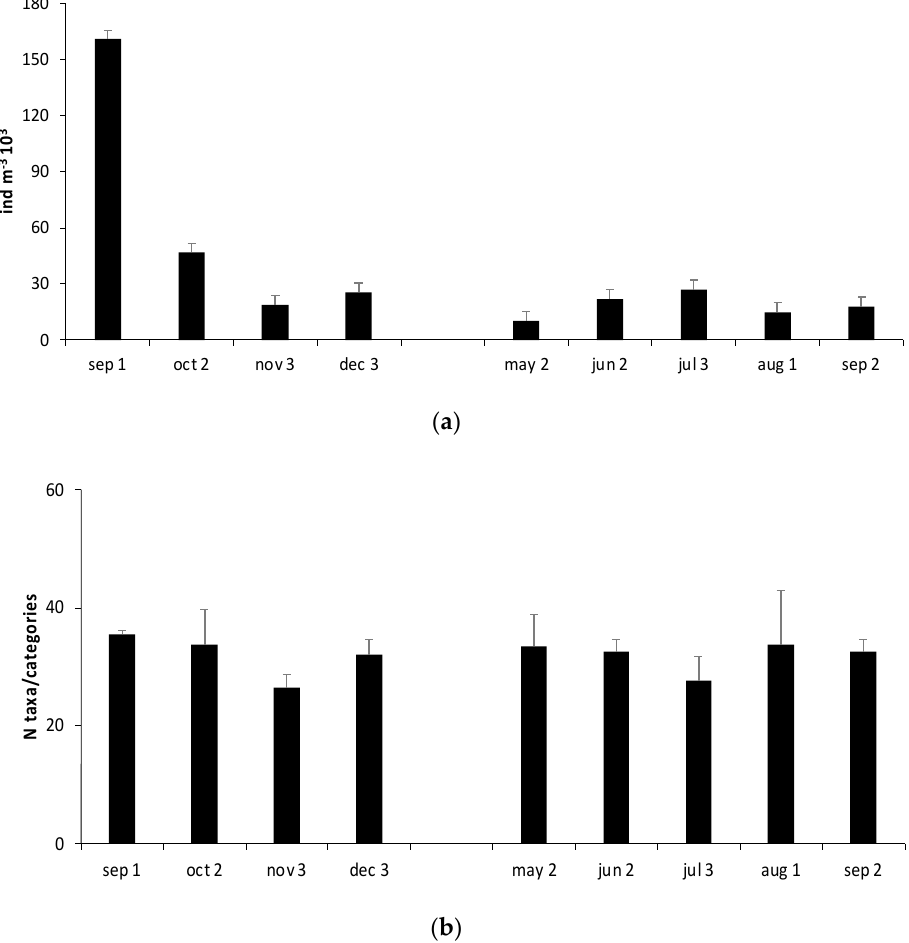
Figure 5. Temporal variation (abundance and taxa richness) of zooplankton in the water column. ( a ) Total abundance (average ± SD); ( b ) taxa richness.